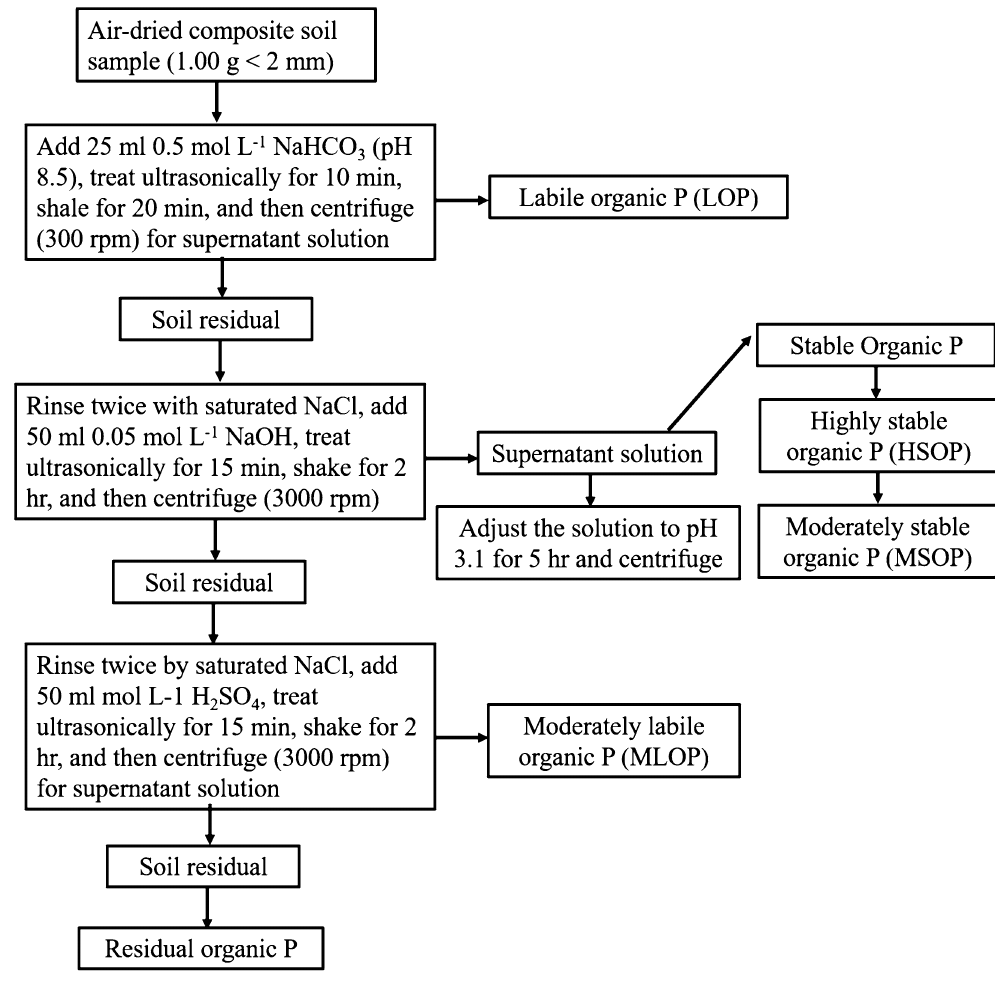
Figure 1. Scheme of sequence extraction of organic P in a